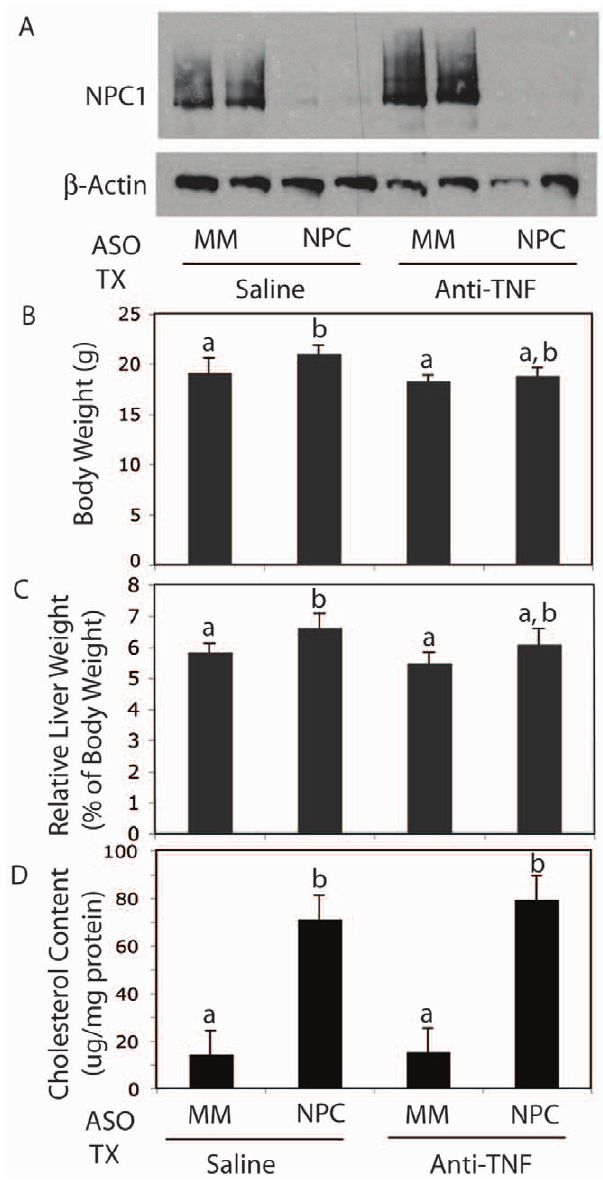
Figure 1. Effect of NPC1 knockdown and anti-TNF treatment on NPC1 protein levels, whole body weight, liver weight, and hepatic cholesterol content. A: Expression of NPC1 in livers of mice injected for 9 weeks with mismatched (MM) and NPC1-specific ASOs and subjected to treatment (TX) with saline or anti-TNF. b -Actin was used as a loading control. Whole body weight (B), relative liver weight (C) and hepatic unesterified cholesterol content (D) in mice injected with mismatched (MM) and NPC1-specific ASOs and subjected to treatment (TX) with saline or anti-TNF. Each bar represents the mean 6 SD of 5 animals in each treatment group. The lettering (a, b) shows statistically dissimilar groups. Samples with two letters represent values that are intermediate to the statistical groups and are thus not considered significantly different from either group.